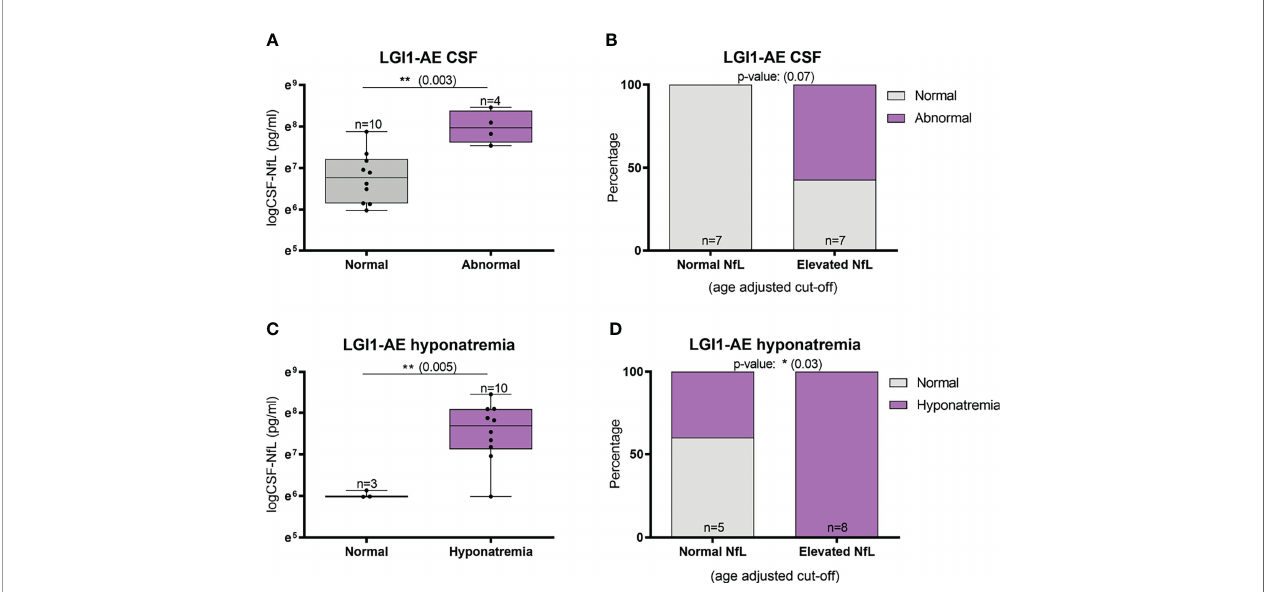
FIGURE 5 | CSF-Neuro fi lament light chain (NfL) levels and abnormal CSF fi ndings and hyponatremia in LGI1-AE patients. In LGI1-AE patients, an abnormal CSF fi nding (pleocytosis, elevated protein or oligoclonal bands) was associated with higher NfL levels at diagnosis (A) and patients with normal NfL levels at diagnosis always had normal CSF fi ndings (B) . In addition, higher NfL levels at diagnosis was associated with the presence of hyponatremia (C) , and all patients with elevated NfL levels presented hyponatremia during the acute phase (D) . *p value < 0.05, **p value <